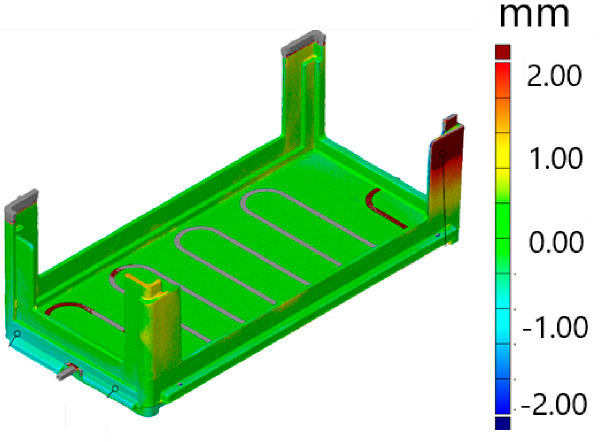
Figure 3. Three-dimensional measurement of the real components by means of fringe light projection and comparison with the CAD target geometry .